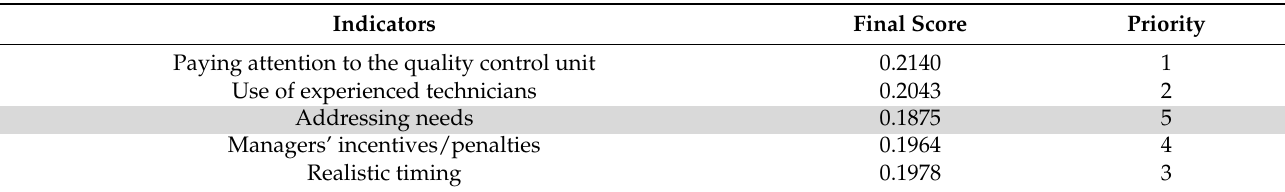
Table 25. Priority related to attention to planning